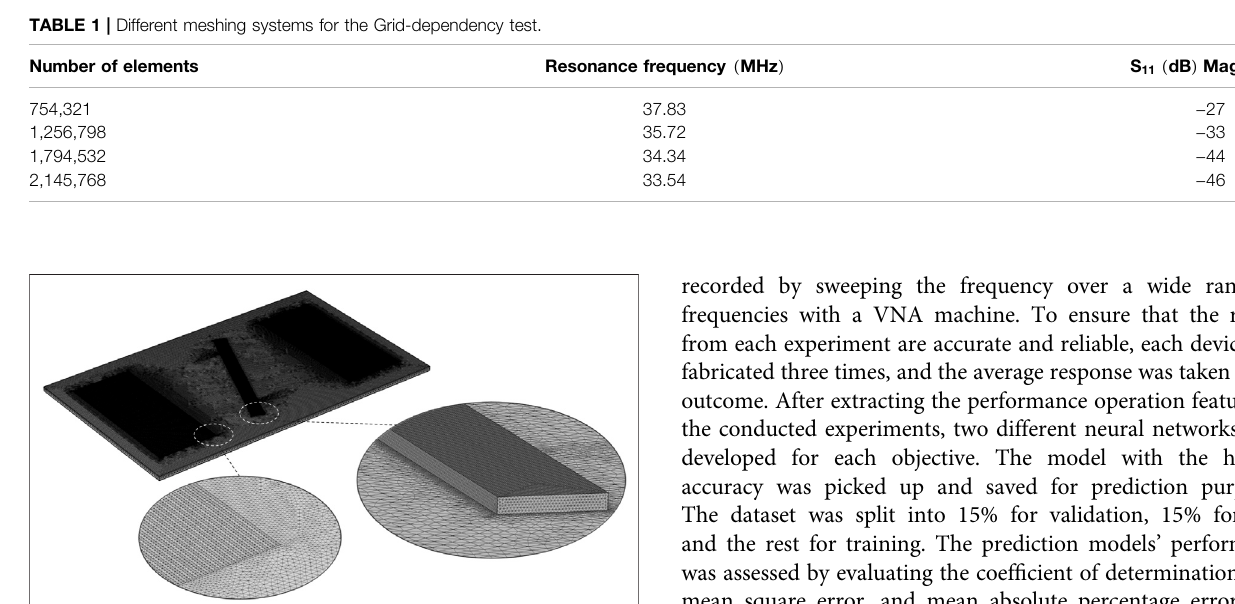
FIGURE 3 | Numerical grids of a 3D acoustic actuator.